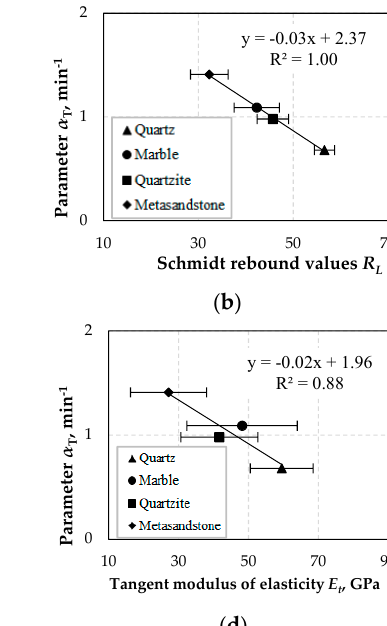
y = 34.72x -0.81 R² = 0.97